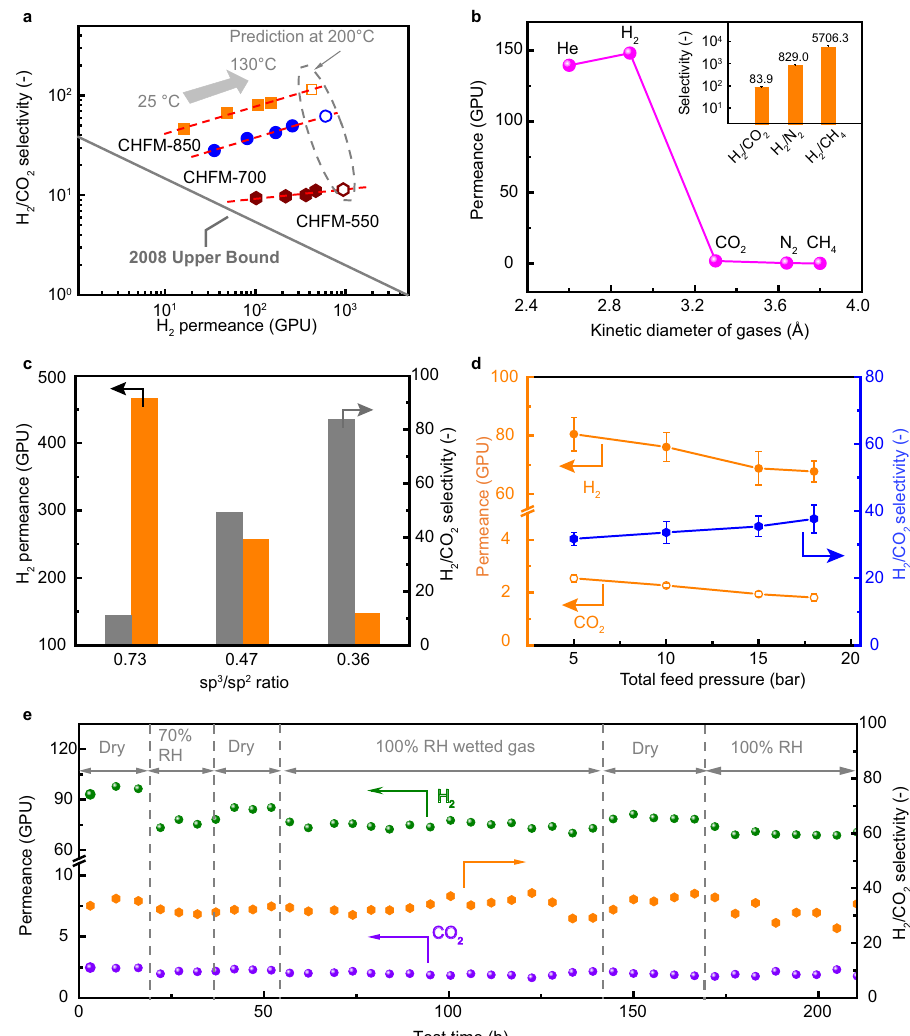
Fig. 3 Gas separation performances of the prepared carbon hollow fi ber membranes (CHFMs). a Single-gas permeation performances of CHFMs at 25, 60, 100, and 130 °C with 2 bar feed pressure. Hollow symbols represent predicted performance at 200 °C. The gray solid line is drawn based on the 2008 Robeson upper bound by converting permeability to permeance with a thickness of 1 μ m. b Single-gas permeances of CHFM-850 as a function of the gas kinetic diameter at 130 °C and 2 bar. The inset fi gure shows the selectivity of H 2 over CO 2 , N 2 , and CH 4 (error bars represent the standard deviation of three measurements). c Gas separation performance at 130 °C as a function of sp 3 / sp 2 ratio, calculated from XPS data. d 50 mol% H 2 /50 mol% CO 2 mixed gas measurements at different operation pressures (5 ‒ 18 bar) at 70 °C (error bars represent the standard deviation of three